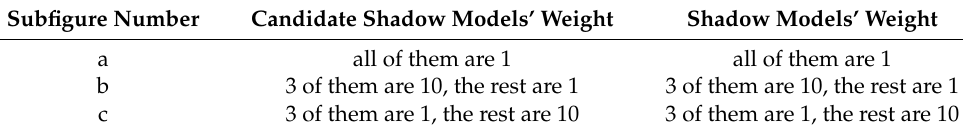
Table 1. The correspondence between the subgraph and the determined sharing state. Subfigure Number a 3 of them are 10, the rest are 1 3 of them are 10, the rest are 1 3 of them are 1, the rest are 10 3 of them are 1, the rest are 10